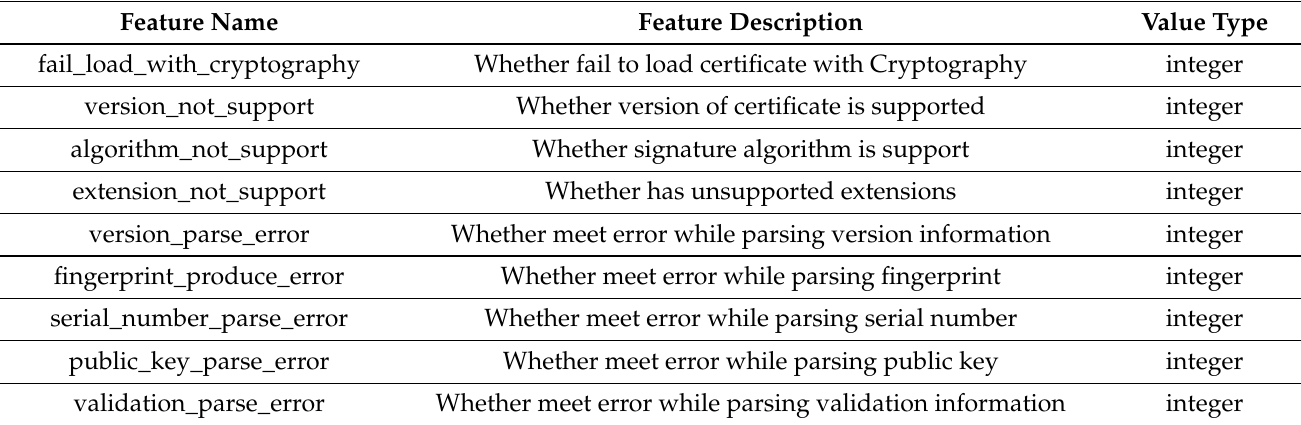
Table 3. Sample features from